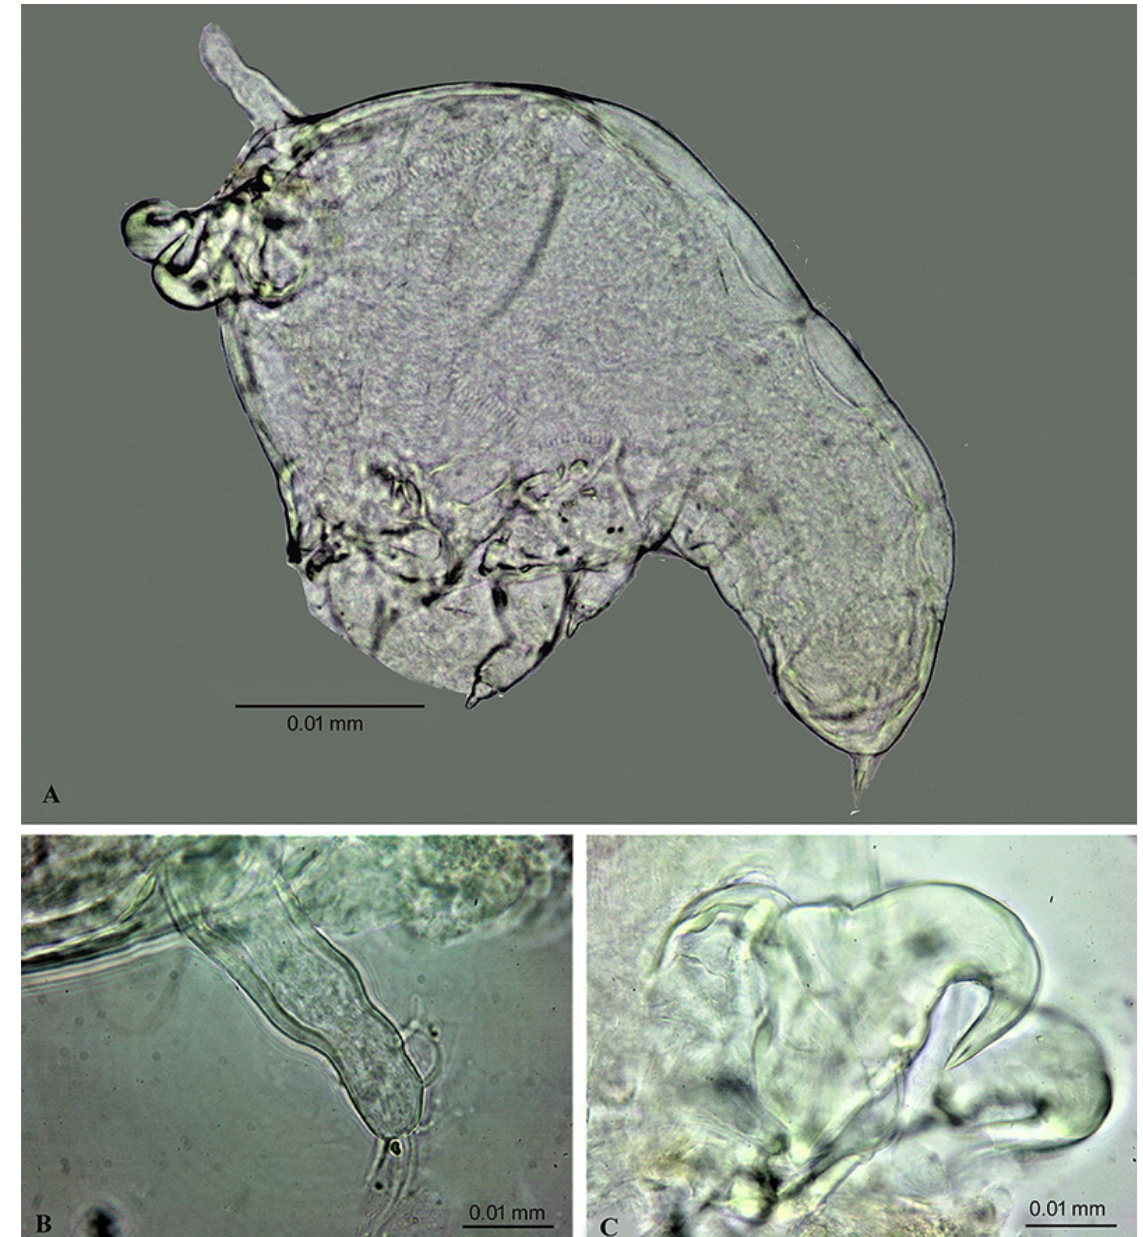
Figure 5. Acanthochondria krishnai sp. n., non-type male from Uranoscopus guttatus Cuvier. A . Habitus lateral view. B . Antennule. C .